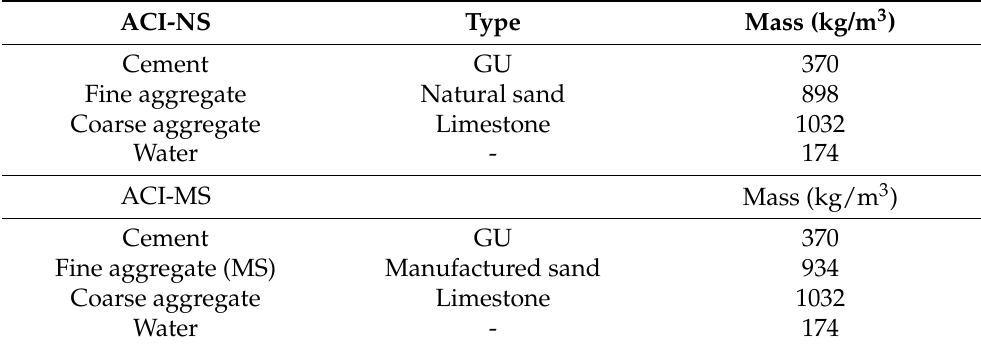
Table 1. Companion conventional concrete mix design